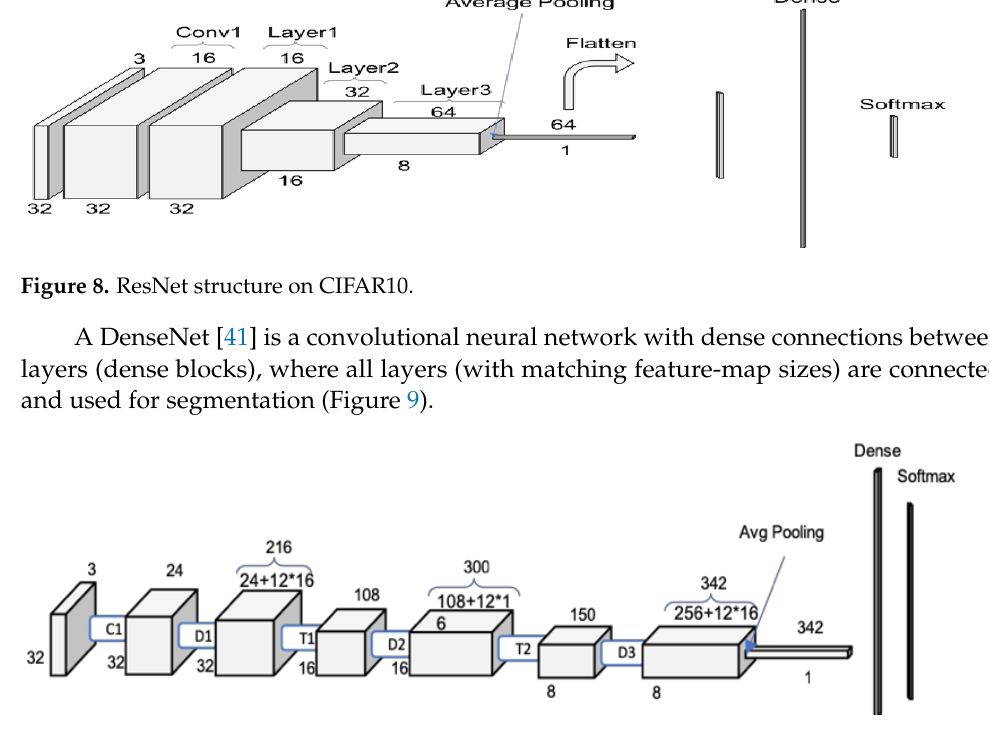
Figure 9. DenseNet on CIFAR10 [with a first single convolutional layer, followed by two pairs of dense blocks, and a third dense block followed by the global average pooling. Comparative